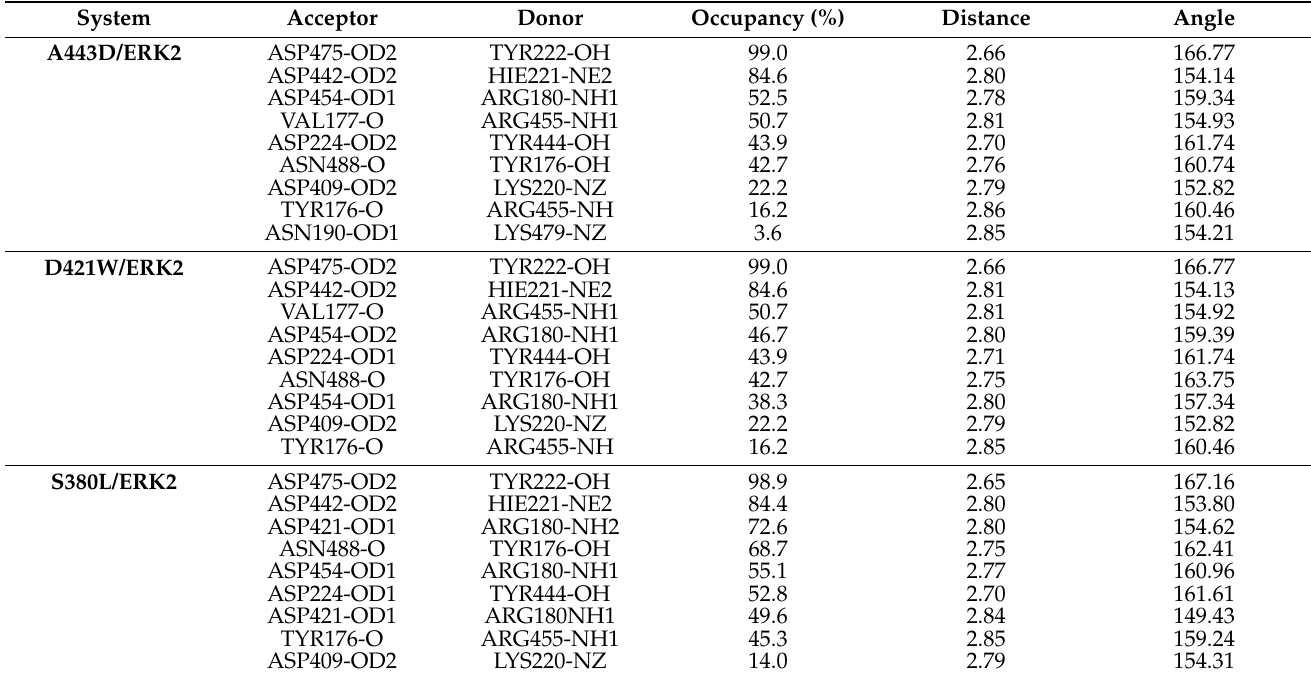
Table 4. Distance, occupancy, and angle of the hydrogen bonds formed from ERK2-A443D/D421W/S380L.